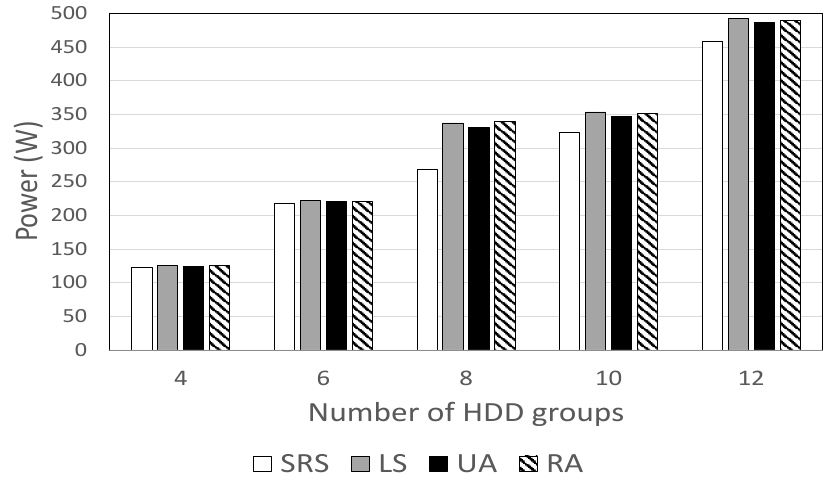
Figure 4. HDD power consumption against the number of HDD groups.